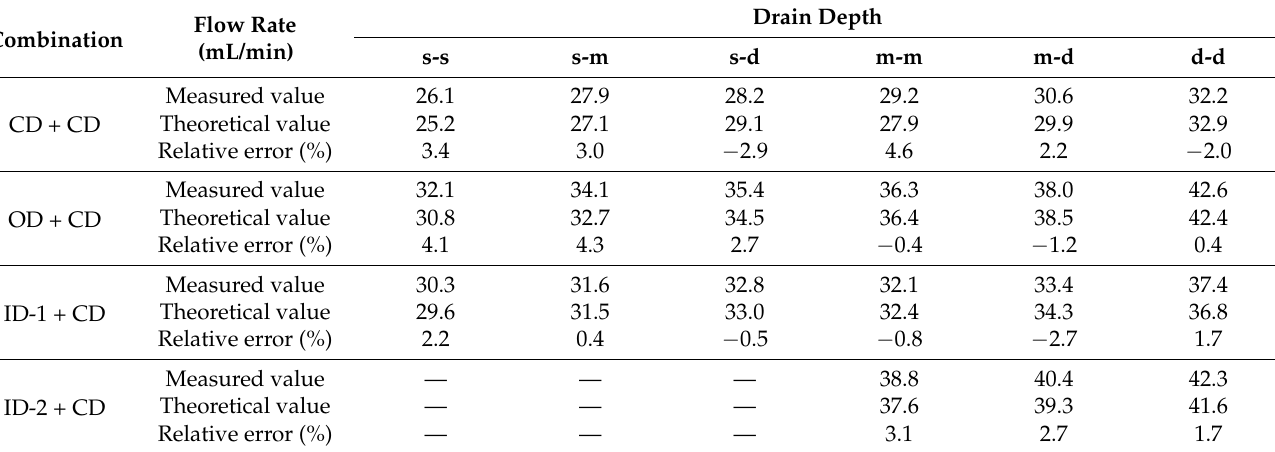
Table 3. Comparison of flow-rate results between the laboratory test and the theoretical